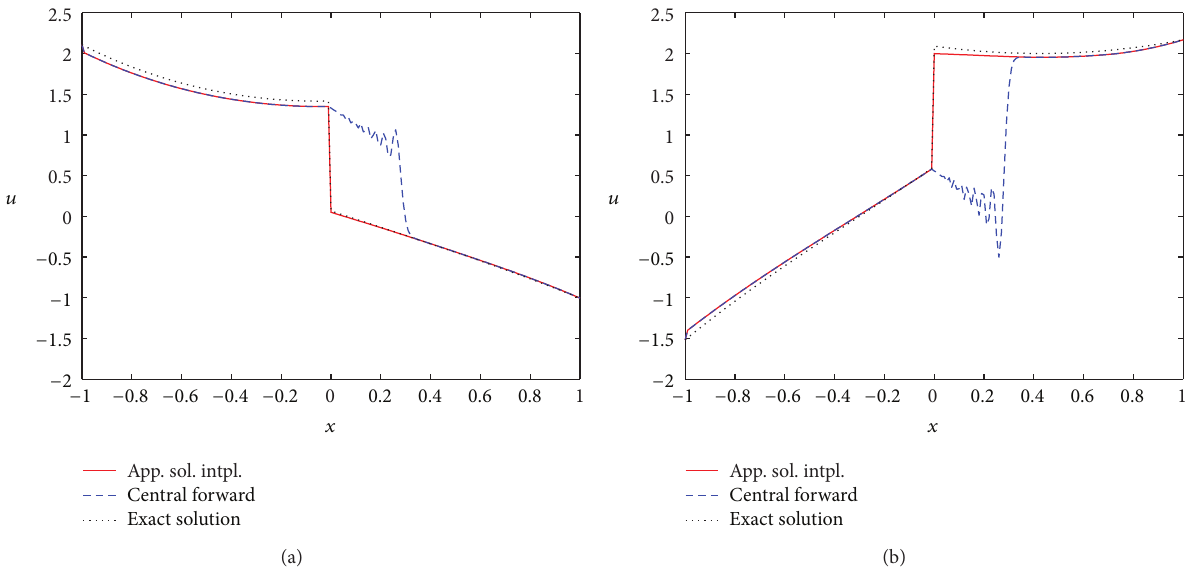
Figure 7: Snapshots of numerical solutions for (43) at 𝑡 = 0.3 . In (a), the exact solution is 𝑢 = exp (𝑥 − 𝑡) − exp (−𝑥 + 𝑡)/2 if 𝑥 < 0 and 𝑢 = exp (−𝑥/√2 − 𝑡) − exp (𝑥/√2 + 𝑡)/2 otherwise. In (b), the exact solution is 𝑢 = exp (𝑥 + 𝑡) − exp (−𝑥 − 𝑡) if 𝑥 < 0 and 𝑢 = exp (𝑥/√2 − 𝑡) + exp (−𝑥/√2 + 𝑡)